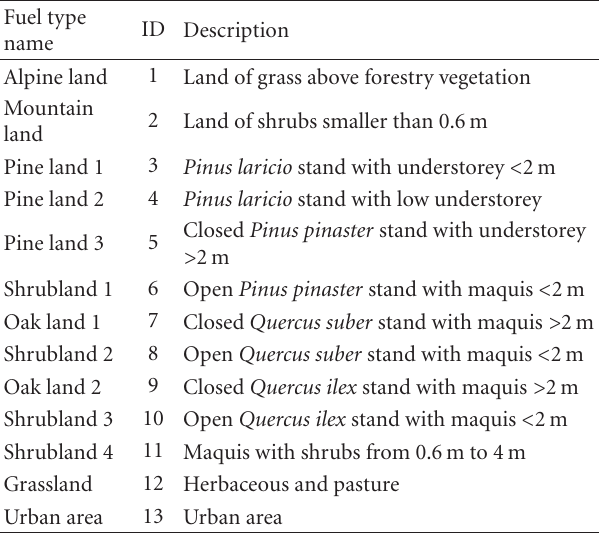
Table 1: The main fuel complexes identified for Corsican